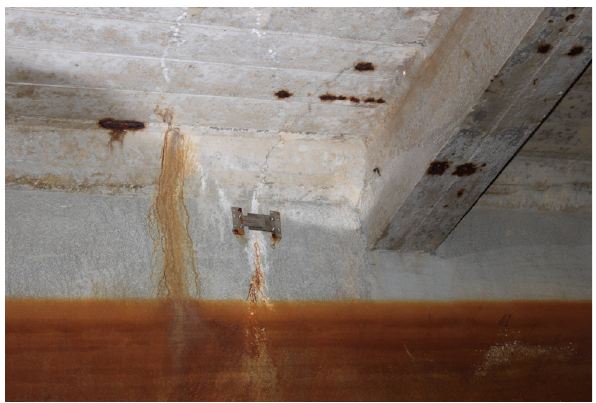
Figure 10: The crack width gauge fixed to the longitudinal partition